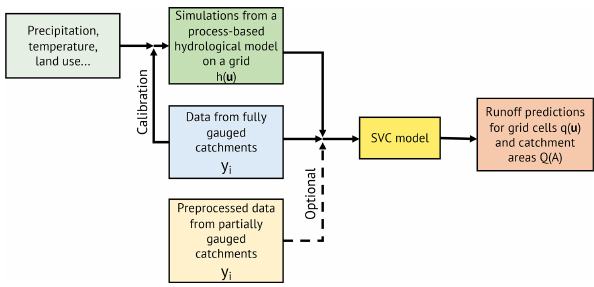
Figure 4. Workflow for estimating runoff for grid nodes q( u ) and for catchment areas Q( A )